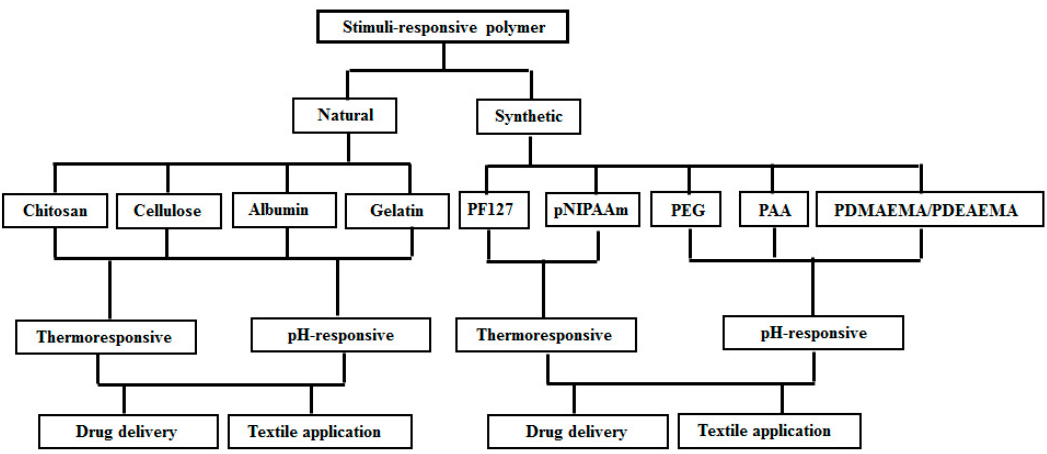
Figure 3. The flowchart outlining the selection of stimuli-responsive polymers and their